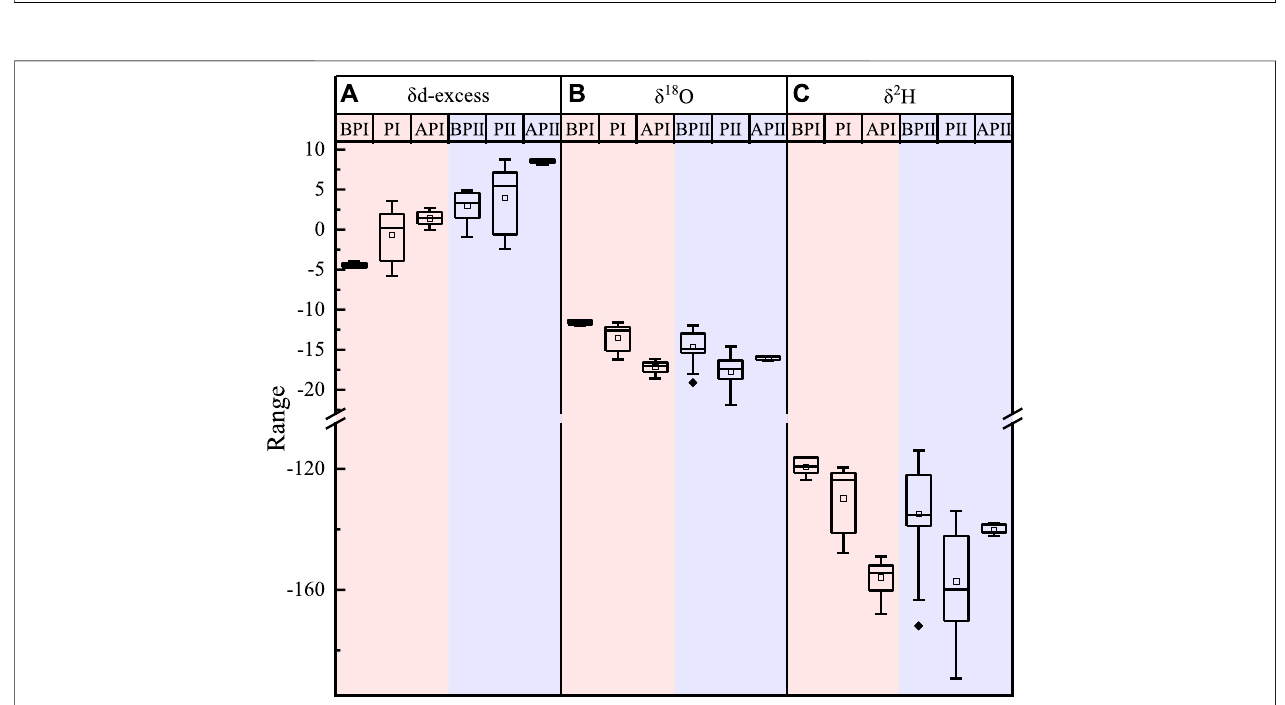
FIGURE 9 | Variation trends of d-excess (A) , δ 18 O (B) , and δ 2 H (C) in the atmospheric water vapor before and after the precipitation event. BP represents the atmospheric water vapor isotope of the day before the precipitation event, P represents the time of the main precipitation event, AP represents one day after the precipitation event, I represents the large precipitation event that occurred on 26 June 2019, and II represents the large precipitation event that occurred on 12 September 2019.